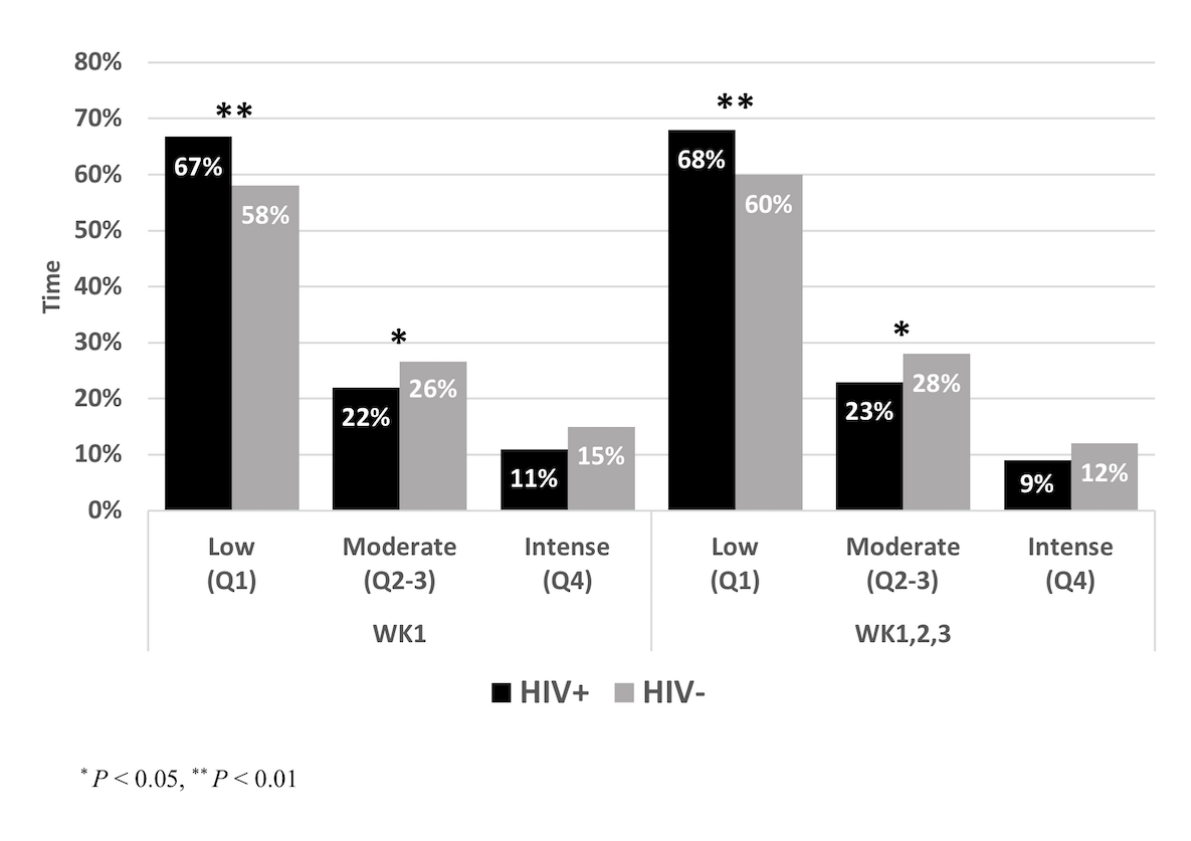
Figure 1. Comparison of free-living activity patterns between men living with HIV (HIV+) and uninfected men (HIV–), represented as mean percent time spent at different activity levels.